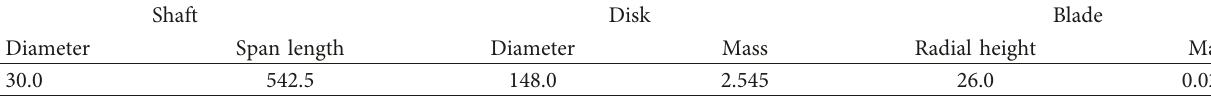
Table 1: Key parameters of the rotor.